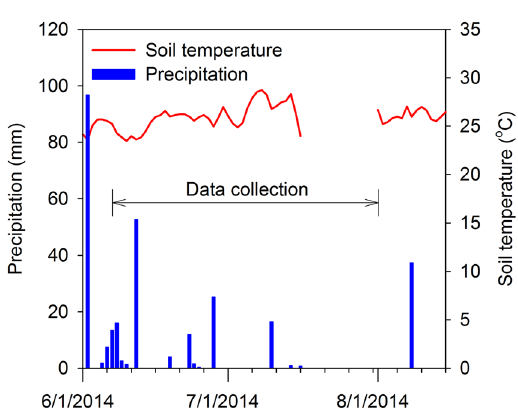
Figure 2. Direct linear relation between change in moisture (0–12 cm) and change in conductivity (10–25 cm) after inversion with data from just below the soil surface in the inverted datasets in soil profile across all vegetation cover types in the experimental site.